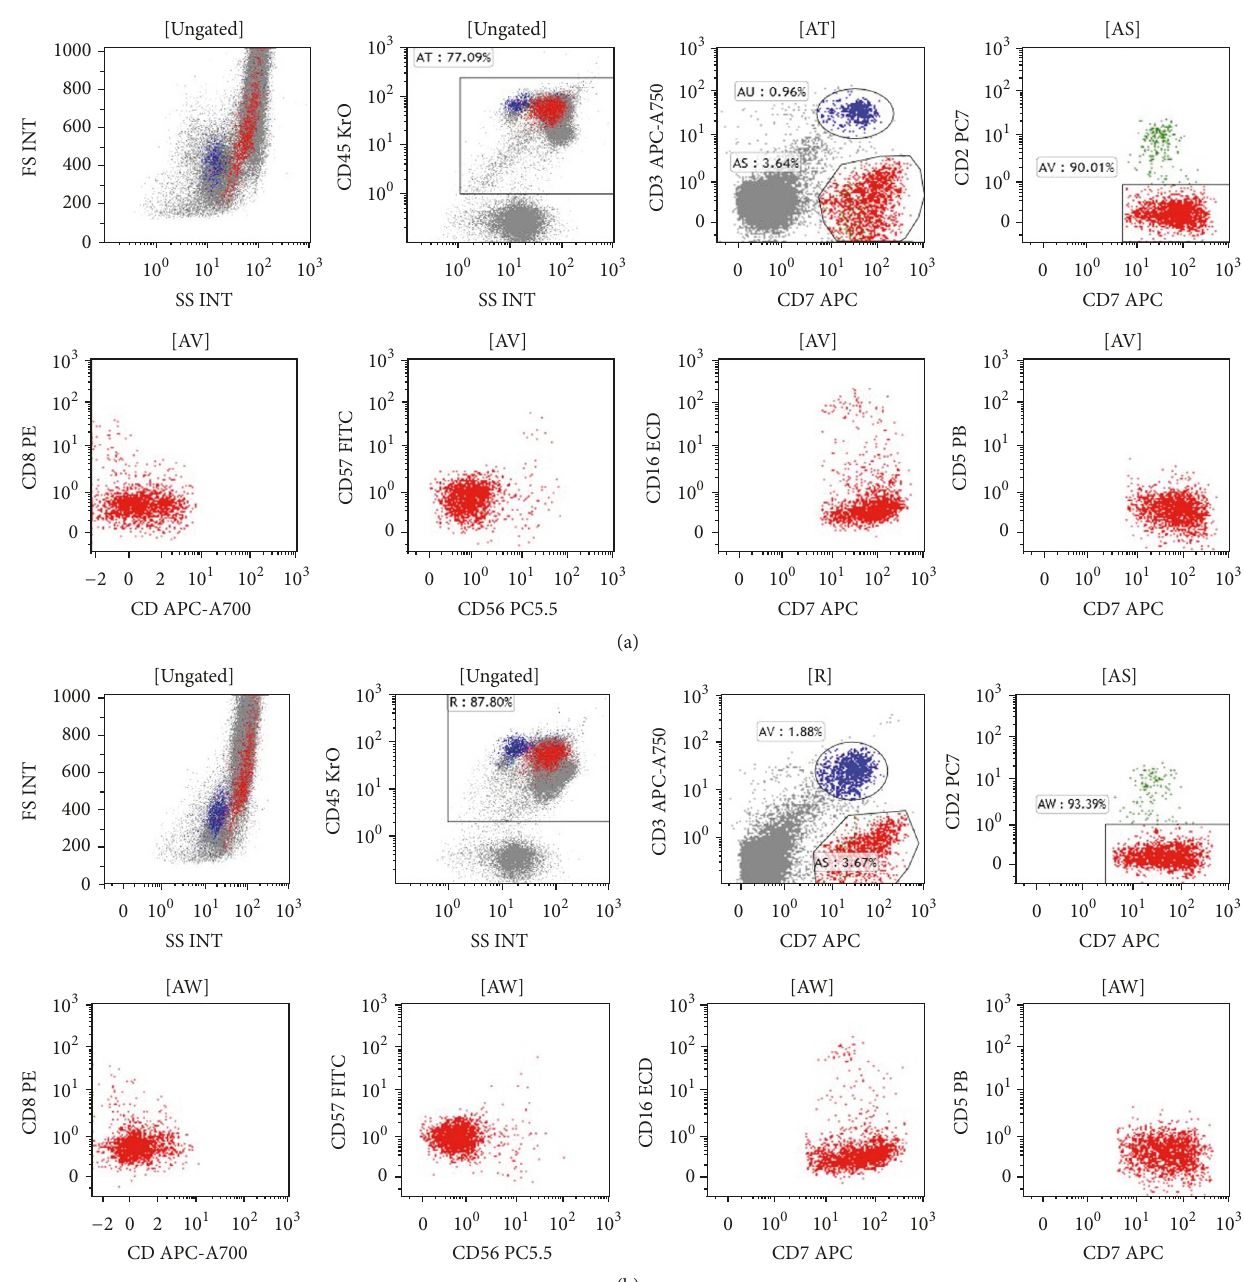
Figure 2: Peripheral blood and bone marrow aspiration analyzed by flow cytometry. Flow cytometry analysis of peripheral blood (a) and bone marrow (b) revealed a similar small population of atypical lymphocytes (red) which are positive for CD45 and CD7 and negative for CD2, CD3, CD4, CD5, CD8, CD16, CD56, and CD57. Normal T-cells are in blue and normal natural killer cells are in